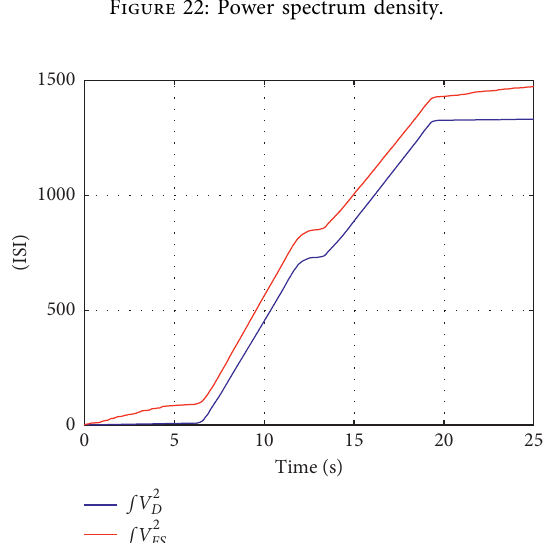
Figure 23: Performance index of the controller.